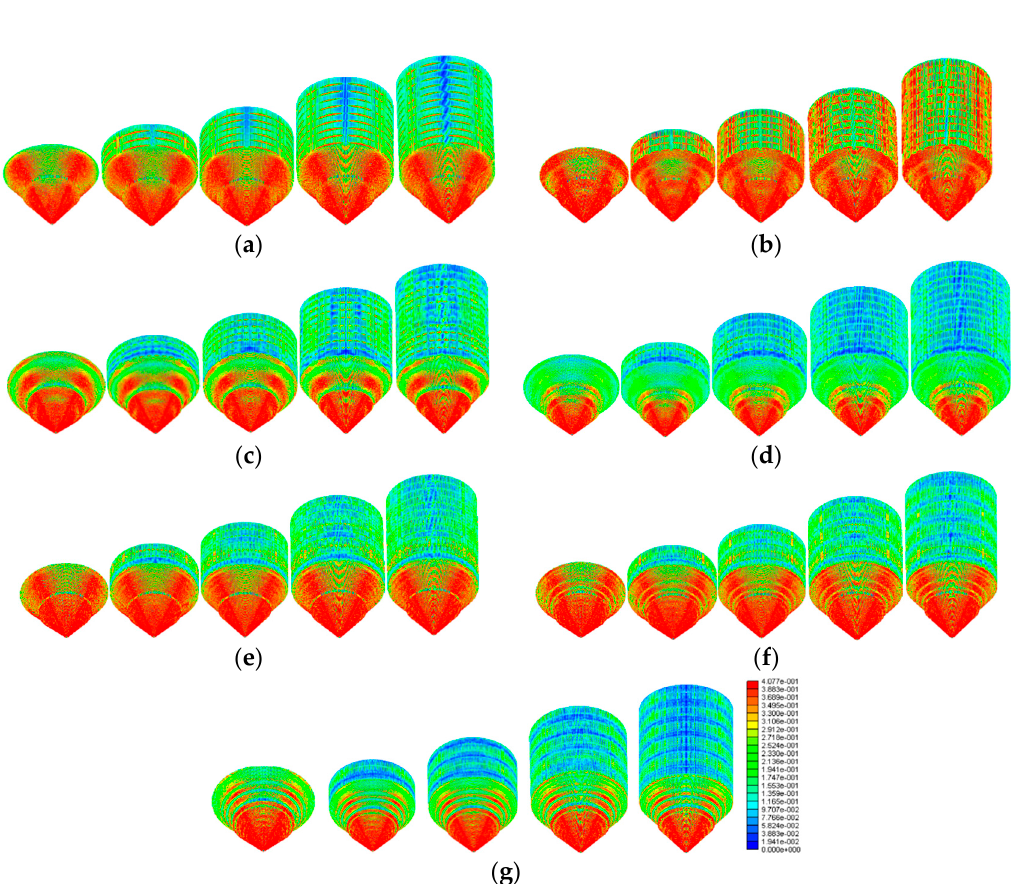
Figure 15. The normalized surface current distributions on the upper cones of the base, 6-ring, 12-ring, 18-ring, and 24-ring-loaded MBAs (from left to right) at ( a ) 7 GHz, ( b ) 17 GHz, ( c ) 27 GHz, ( d ) 37 GHz, ( e ) 47 GHz, ( f ) 57 GHz and ( g ) 67 GHz in the ultra-wideband. Note that, in order to show clearer current distributions, the figure only shows the current distribution values less than or equal to 0.4077, as the higher values more concentrate near the tips of upper cones.